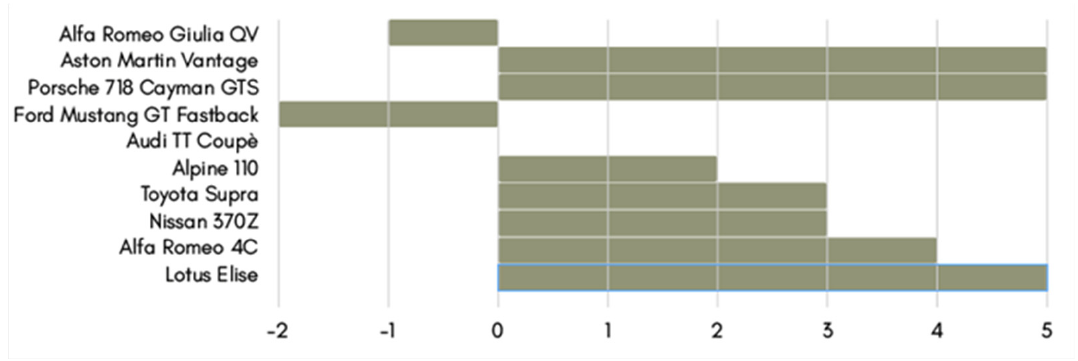
Figure 10. Visual representation of Top-Flop Delta for each vehicle.